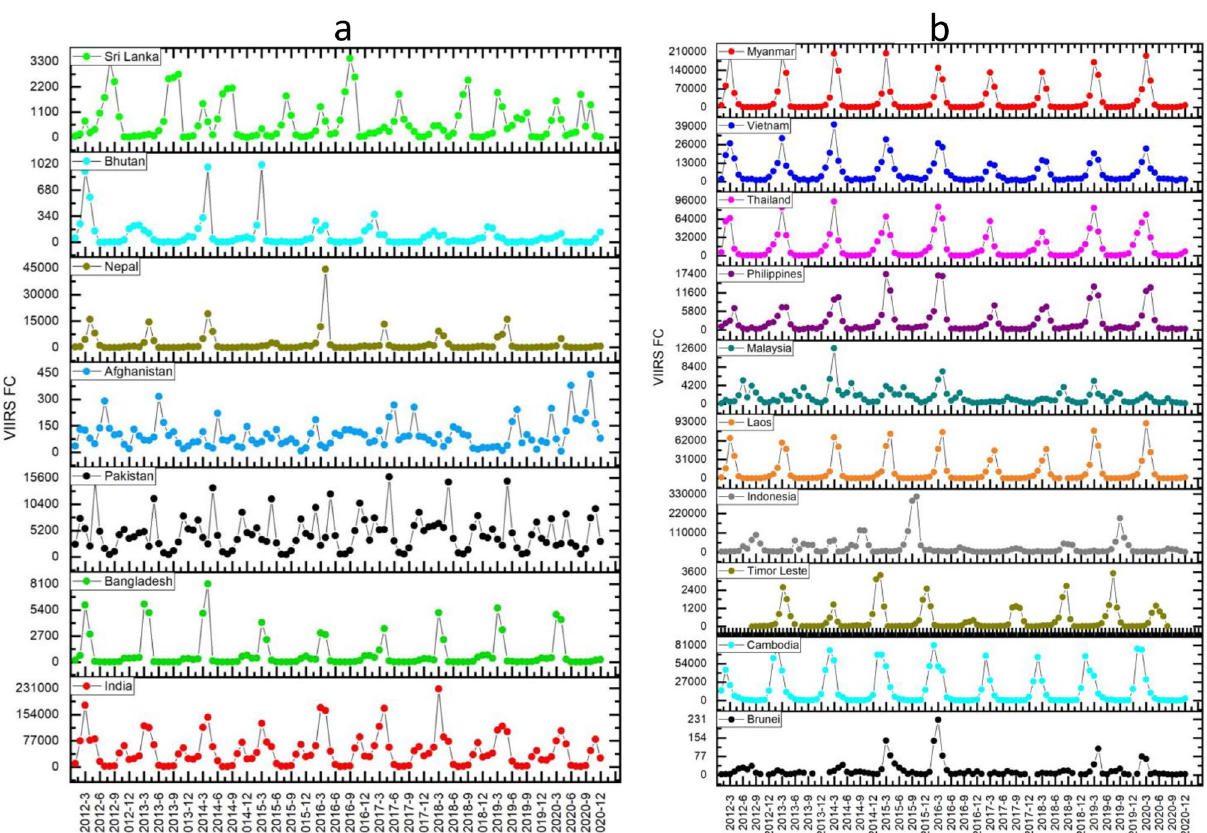
Figure 2. ( a ), ( b ) VIIRS (375 m) retrieved fire counts (FC) for South and Southeast Asian